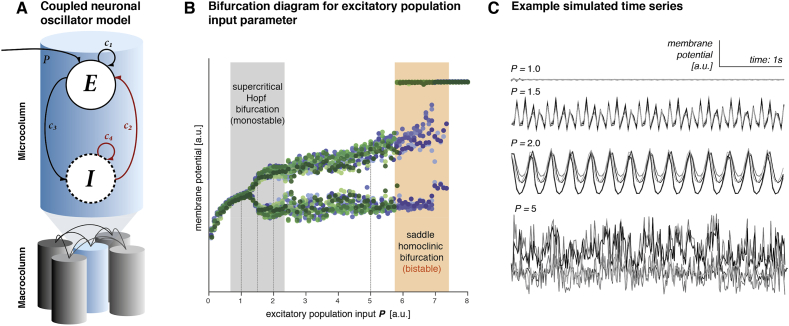
Example of bifurcation behaviour of a set of coupled oscillators. (A) Multiple Wilson-Cowan type neural mass models of excitatory and inhibitory populations were heterogeneously coupled and simulated at different values of excitatory population input P [112]. (B) This graph shows the membrane potential for five coupled microcolumns at steady state for different values of excitatory population input P, with dots of different shades representing a single microcolumn. Stepwise changes in P cause transitions in dynamics from fixed point steady states (shown as single dot per value P) to oscillatory states (shown as peak and trough of the oscillation for each value of P for P > 1.3) and back to fixed point (for P > 7.4). Simulations were run in small increasing (blue), and decreasing (green) steps, revealing bistability in the offset of the oscillation (note that outside of this bistability blue and green are largely overlapping). Even in this simplistic model many different state transition phenomena can be modelled, as sudden switches between high amplitude oscillations and fixed points at the bistable offset bifurcation, where two possible steady states co-exist. (C) Time series examples are shown for increasing values of the parameter P for illustration of different dynamic regimes associated with changes in just the single parameter P. (For interpretation of the references to colour in this figure legend, the reader is referred to the Web version of this article.)